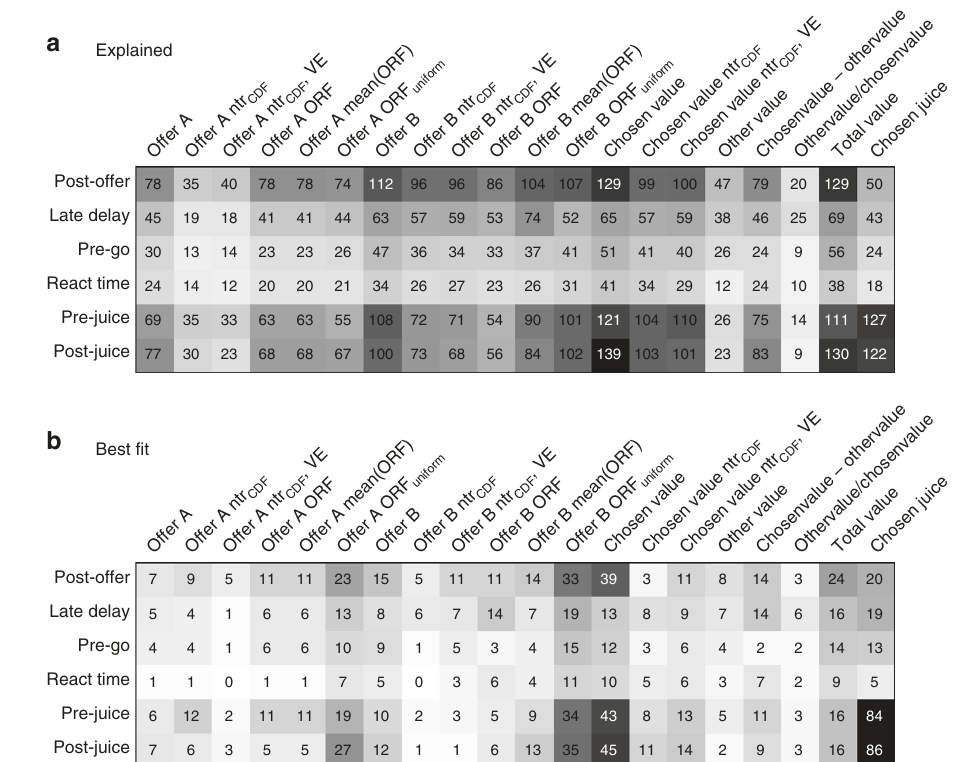
Fig. 8 Population analysis of neuronal responses. Each neuronal response that passed an ANOVA criterion was regressed against each variable. If the regression slope differed signi fi cantly from zero, the variable was said to explain the response (see Methods). a Explained responses. Rows and columns represent time windows and variables, respectively. In each location, the number indicates the number of responses explained by the corresponding variable. For example, in the post-offer time window, the variable offer A (linear response function) explained 78 responses. The same numbers are also represented in grayscale. Each response could be explained by more than one variable. Thus each response might contribute to multiple bins in this panel. b Best fi t. In each location, the number indicates the number of responses for which the corresponding variable provided the best fi t (highest R 2 ). For example, in the post-offer time window, offer A (linear response function) provided the best fi t for 7 responses. The same numbers are also represented in grayscale. In this panel, each neuronal response contributes at most to one bin. Qualitatively, the dominant variables appear to be offer A ORF uniform , offer B ORF uniform , chosen value and chosen juice. Indeed the variable selection procedures identi fi ed these variables as the ones with the highest explanatory power (Fig.